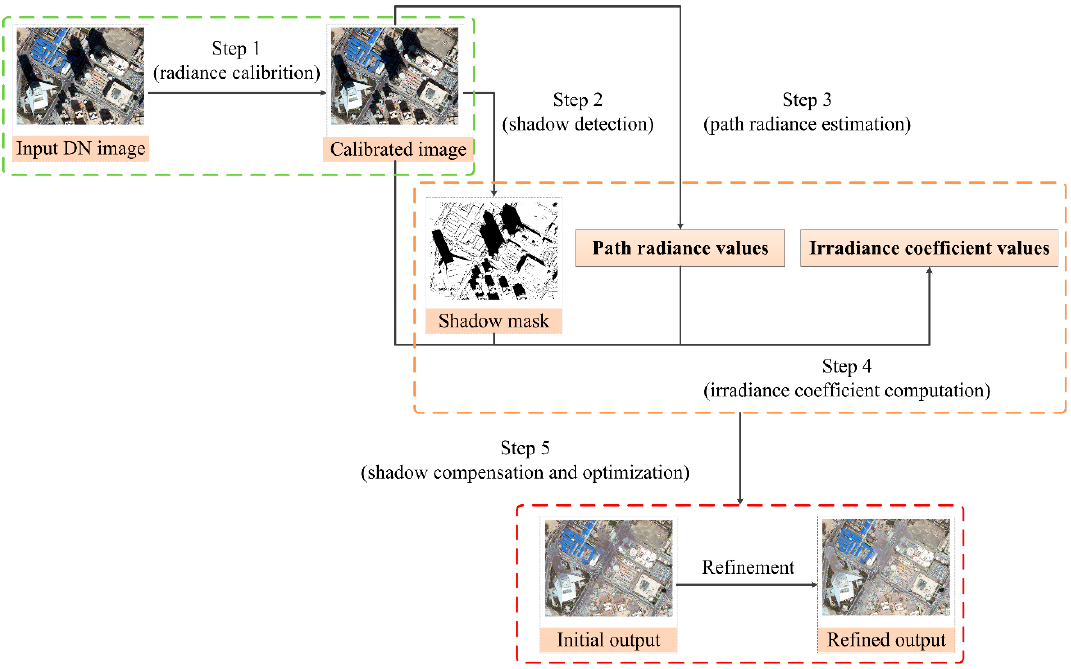
Figure 2. Workflow chart for the IRB approach.